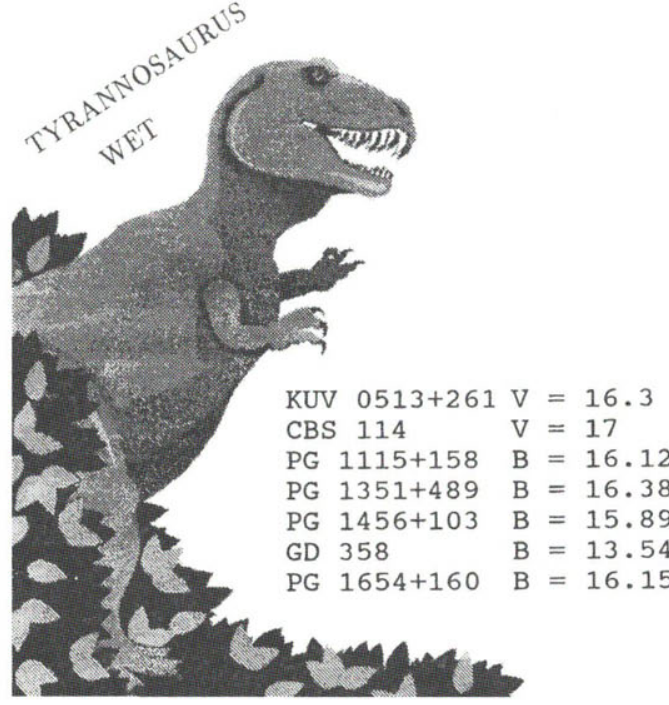
Fig. 3. The fearsome, but visually challenged, Tyrannosaurus